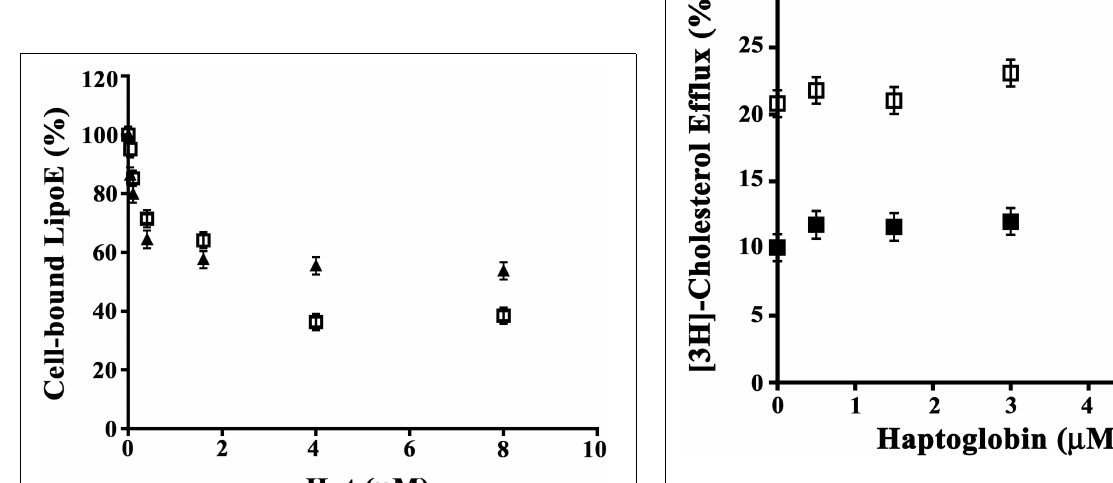
FIGURE 3 | Hpt effect on ApoE-dependent cholesterol efflux. U87-MG were seeded into 96-well plate (15,000 cells per well) and cultured in complete medium for 20h. After medium removal, cells were rinsed with DMEM and labeled by incubation (20h) with [ 3 H]-Cholesterol (0.026 μ Ci/well) in DMEM containing 0.5% FBS. After medium removal, cells were rinsed again, and incubated (5h) in serum-free DMEM containing 0.2% BSA in presence (open squares) or absence (full squares) of 0.15 μ M LipoE and different amounts of Hpt (0–5 μ M). Aliquots (70 μ l) of supernatants and lysates were then analyzed by scintillation counting, and cholesterol effluxed to the medium was calculated as percentage of total radioactivity in the cell lysates and medium. Data were expressed as mean ±